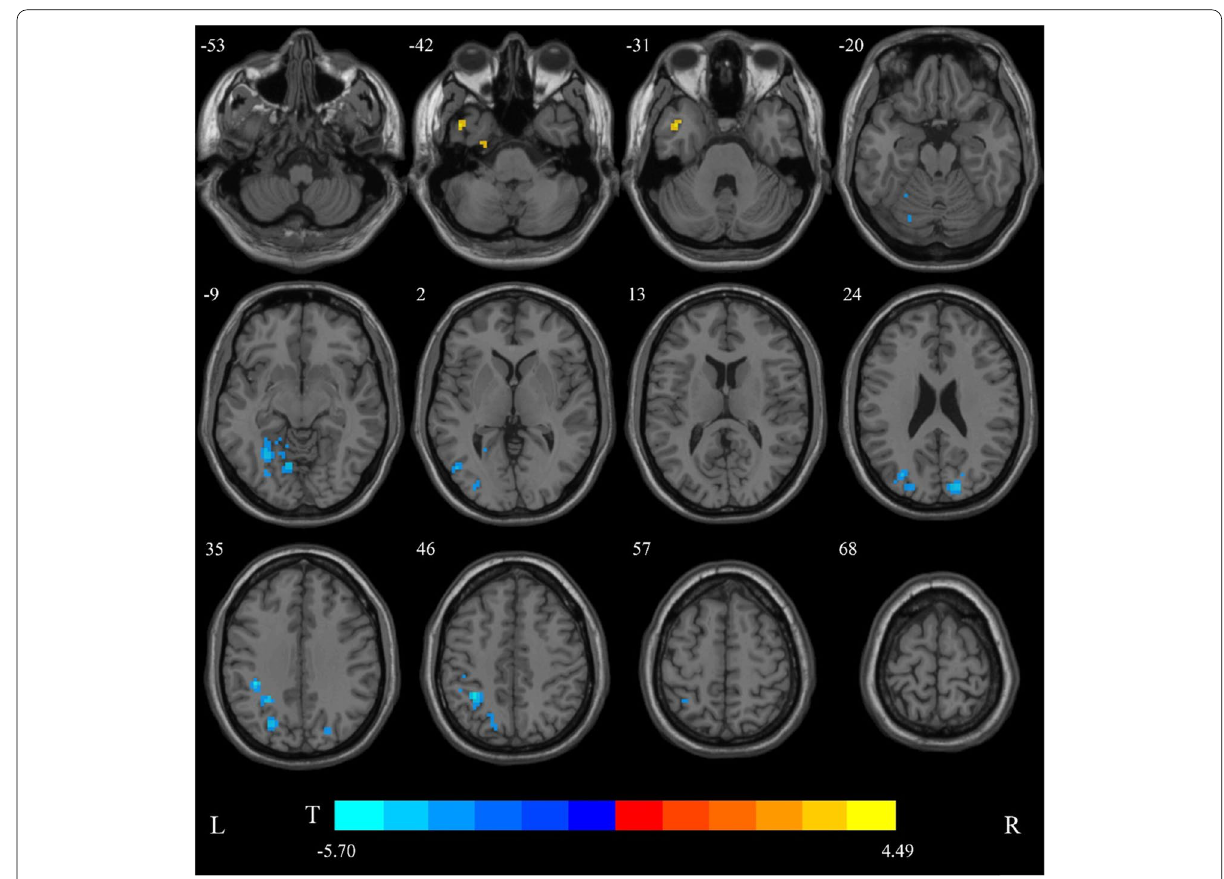
Fig. 1 The group differences of fractional amplitude of low-frequency fluctuation (fALFF) between juvenile myoclonic epilepsy patients with monotherapy and healthy controls. Cold colors indicate decreased fALFF in the left fusiform/lingual gyrus, the middle occipital/superior parietal gyrus, the inferior parietal lobe, the right cuneus/superior occipital gyrus, and the cerebellum. Warm colors indicate an increase in fALFF in the left inferior temporal gyrus (voxel-level P < 0.005, cluster-level P < 0.05, corrected for Gaussian random field